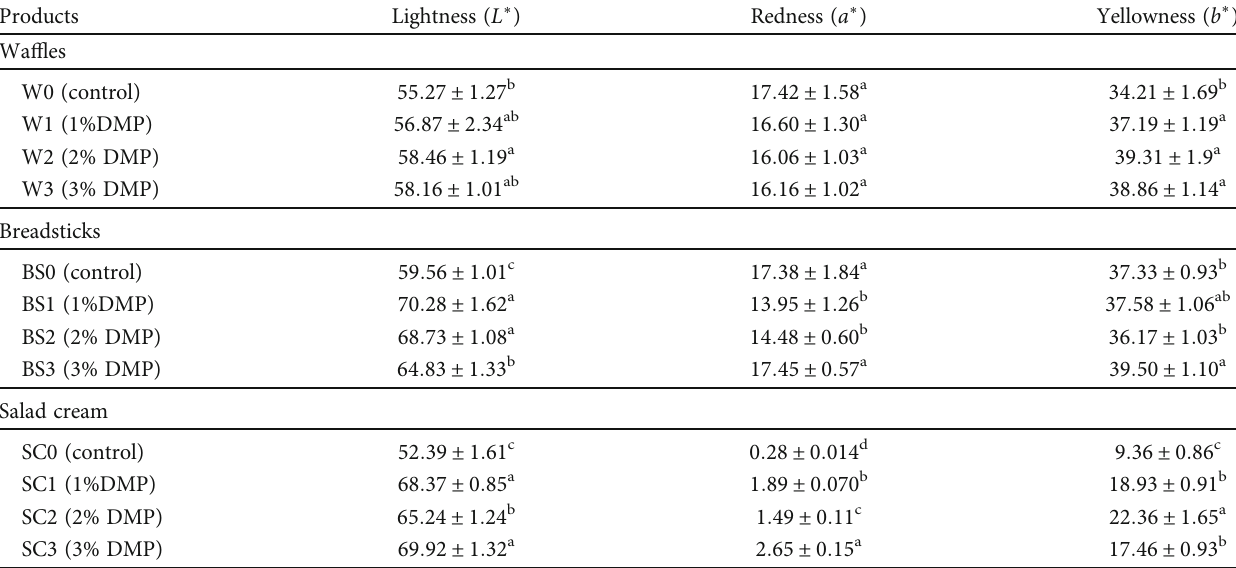
DMP: oyster mushroom powder. Results are reported as mean ± SD of triplicate analysis. Means with the same letters are not signi fi cantly di ff erent ( P < 0 : 05 ) in the same